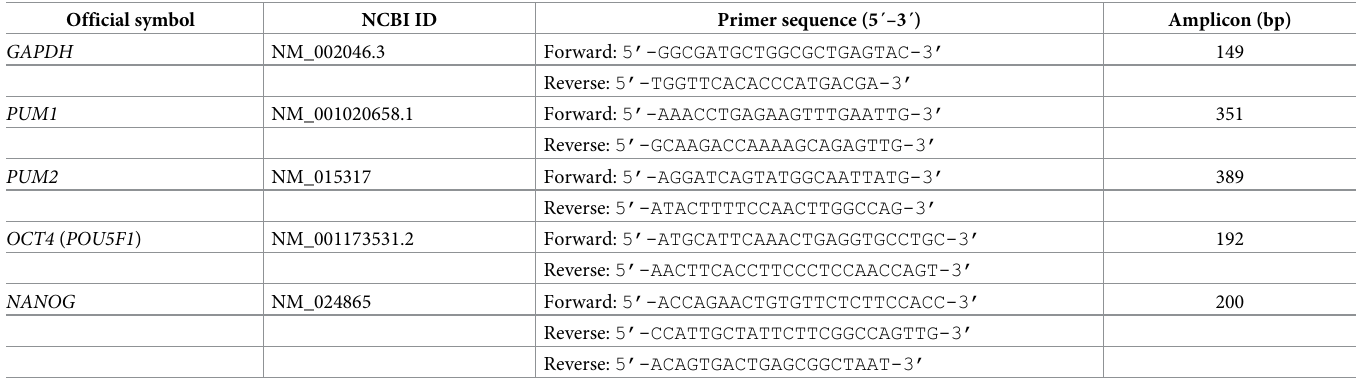
Table 1. Primer sets used for